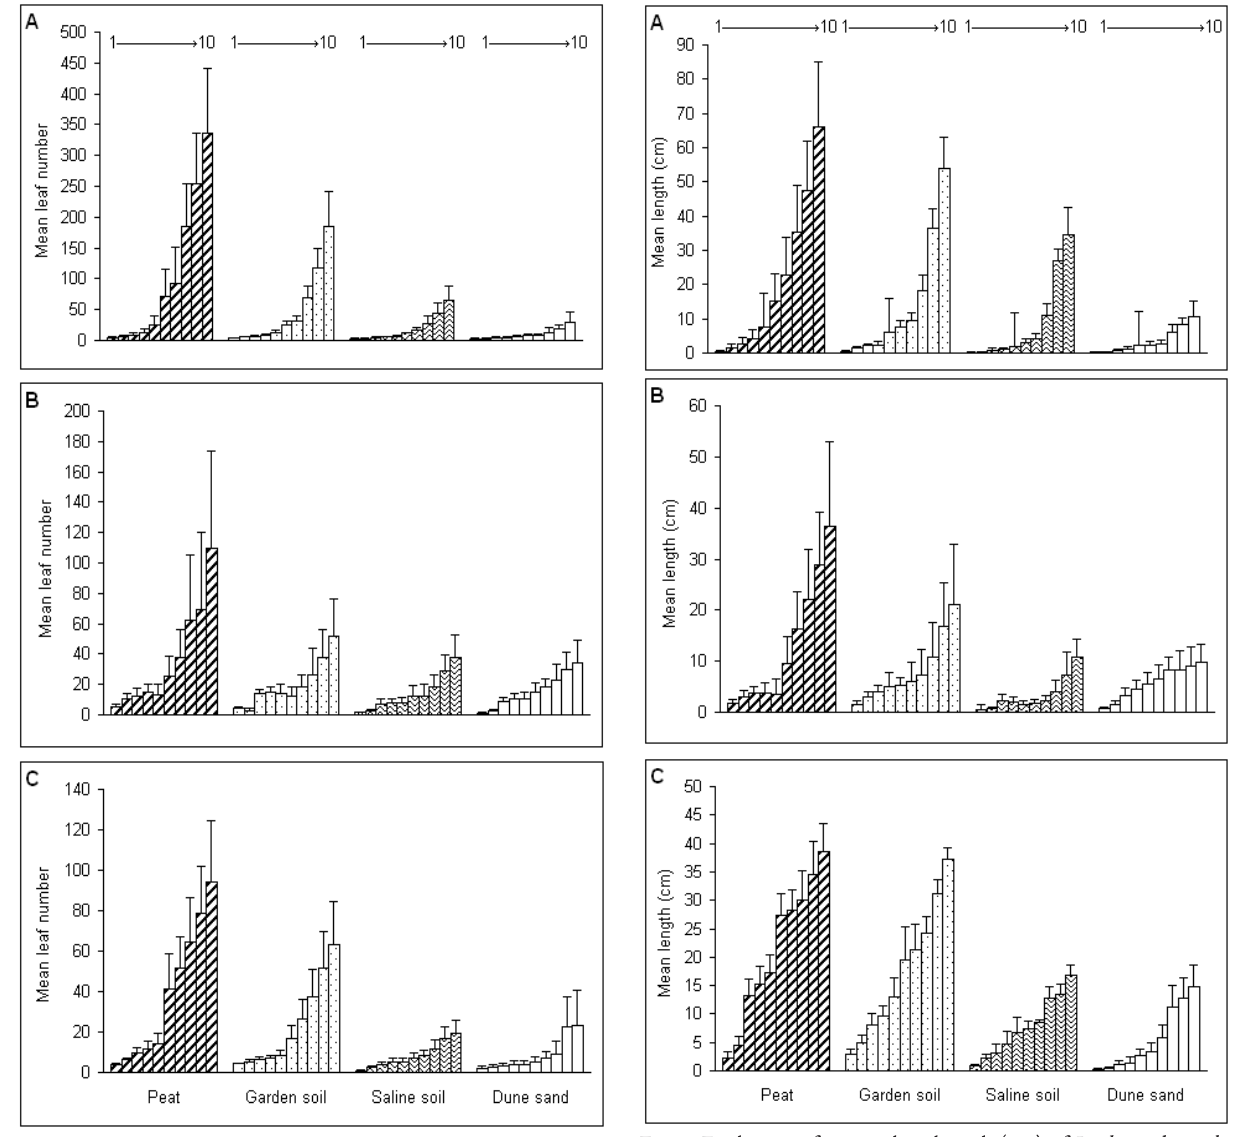
Fig. 1. Evolution of mean leaf number of Inula crithmoides (A), Plantago crassifolia (B) and Medicago marina (C) plants, grown for 10 weeks on the indicated types of substrate